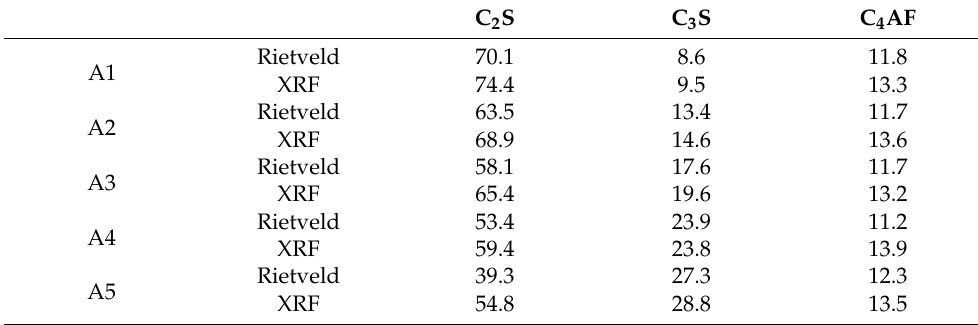
Figure 5. XRD patterns of samples sintered 1350 ◦ C, for 30 min. Table 6. Phase composition (wt.%) of A1–A4 sintered at 1350 ◦ C, for 30 min.